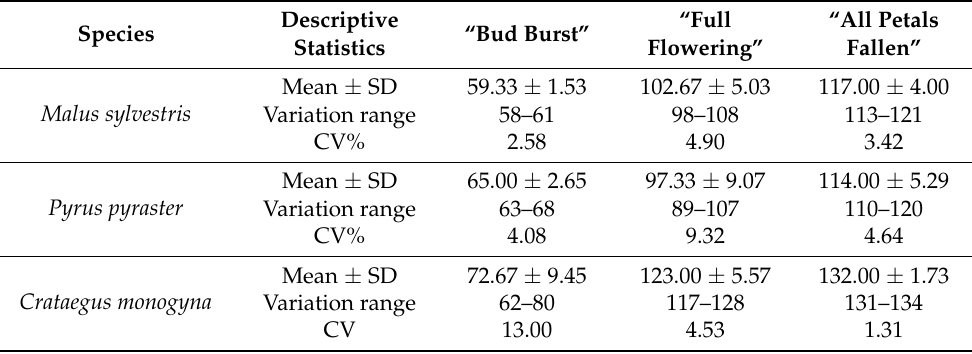
Table 1. Descriptive statistics of the number of days (Julian date) necessary for the development of the main spring phenological